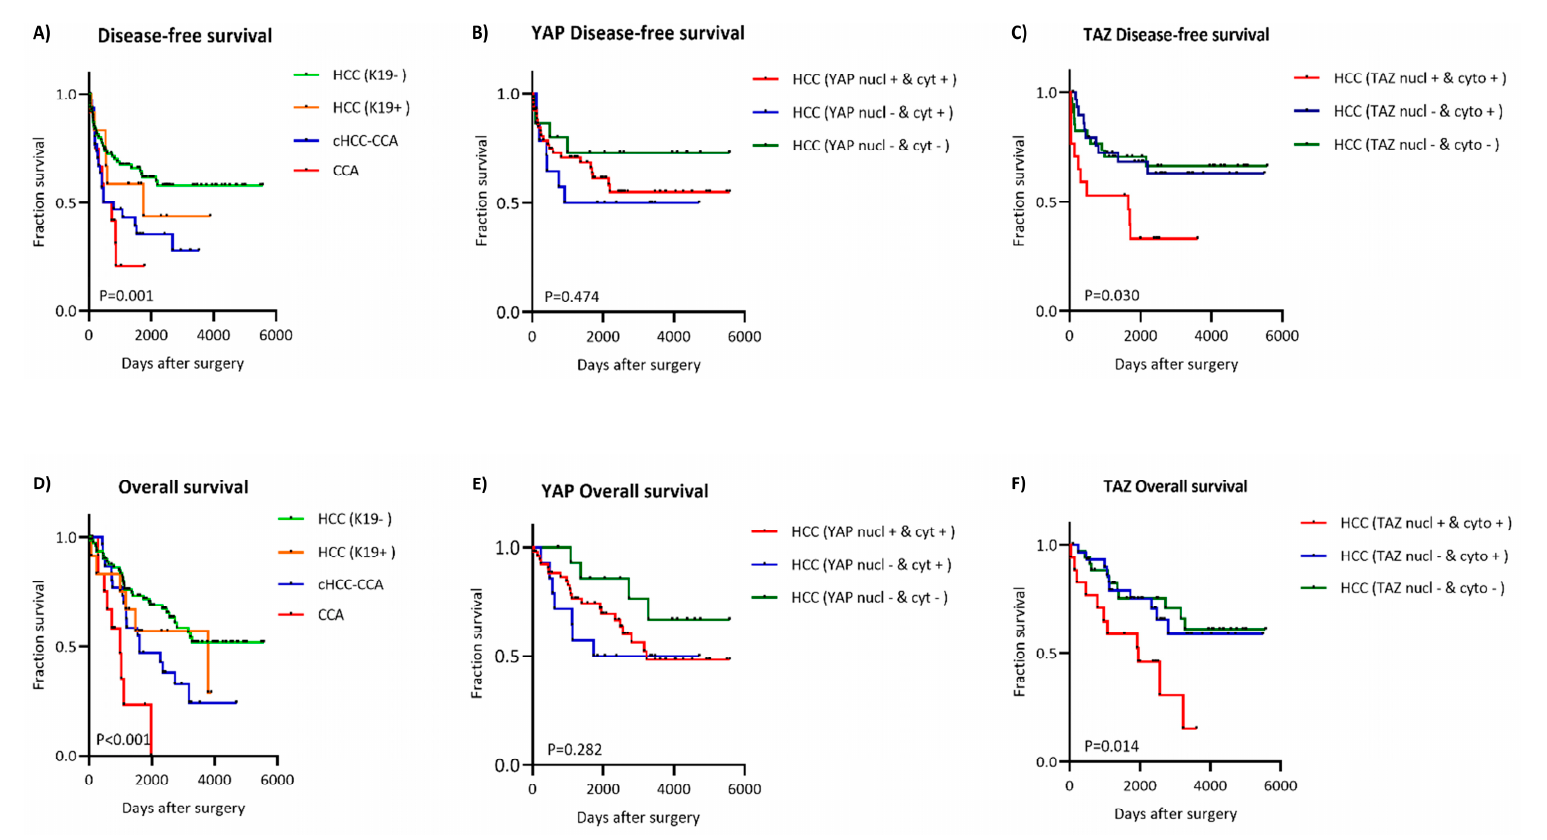
Figure 3. Kaplan–Meier curves for disease-free survival and overall survival are illustrated for the subgroups HCC, cHCC-CCA, and CCA ( A , D ). Expression of YAP in the nucleus and/or cytoplasm in Kaplan–Meier curves for OS and DFS in HCC K19 − ( B , E ). TAZ expression in the nucleus and/or cytoplasm in HCC K19 − ( C , F ).